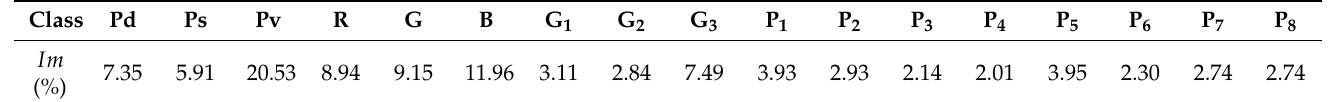
Table 5. Feature importance of each